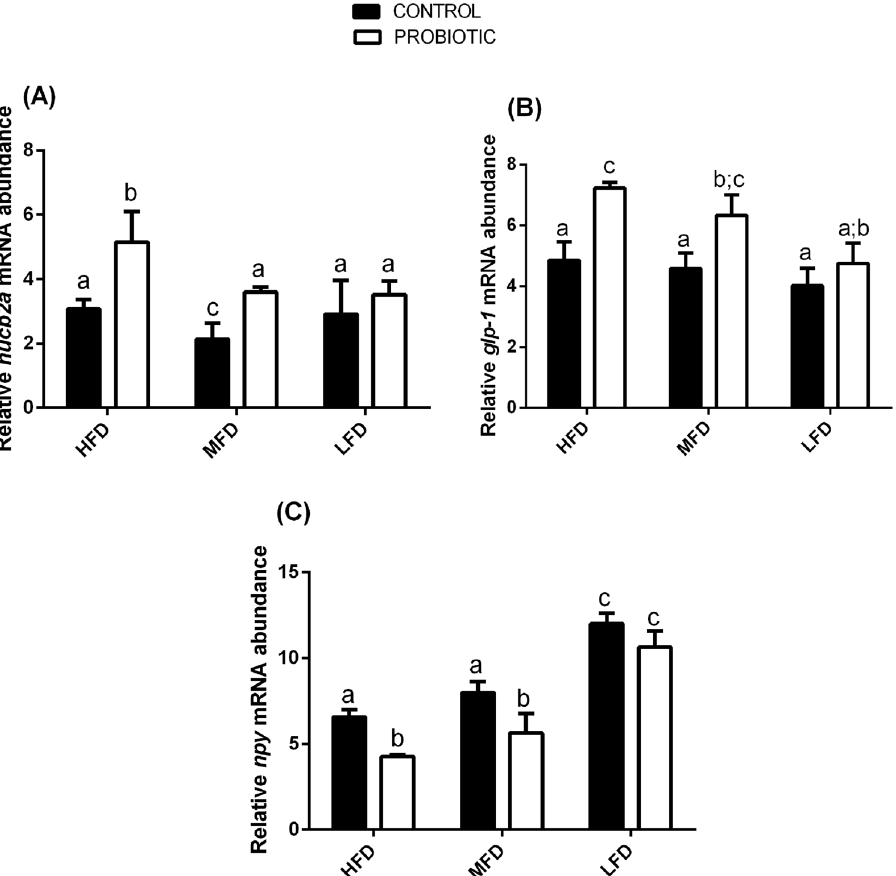
Figure 1. L . rhamnosus modulates the expression of genes involved in the regulation of appetite. Relative nucb2a ( A ), gcga ( B ), npy ( C ), gene expression normalized against β -act and rplp , in fish fed a HFD-C, MFD-C and LFD-C and fish fed a HFD-P, MFD-P and LFD-P. Assays were performed in triplicate. Values with different superscript letters are significantly different ( p <